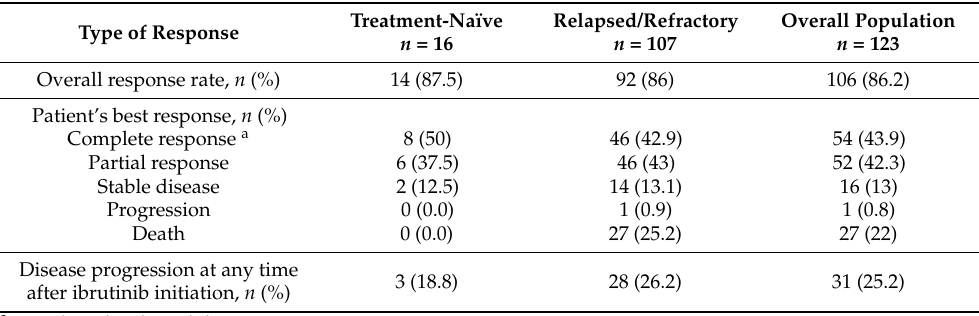
Table 3. Summary of the clinical response to ibrutinib in the treatment-naïve group, relapsed/refractory CLL patients, and overall